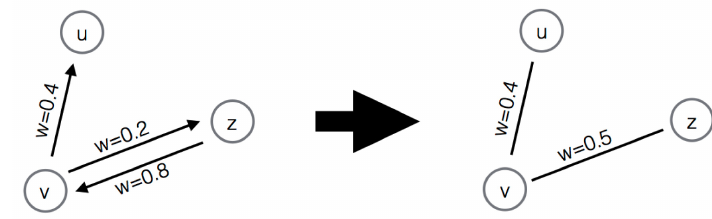
Figure 1. Conversion of a directed network into an undirected one.